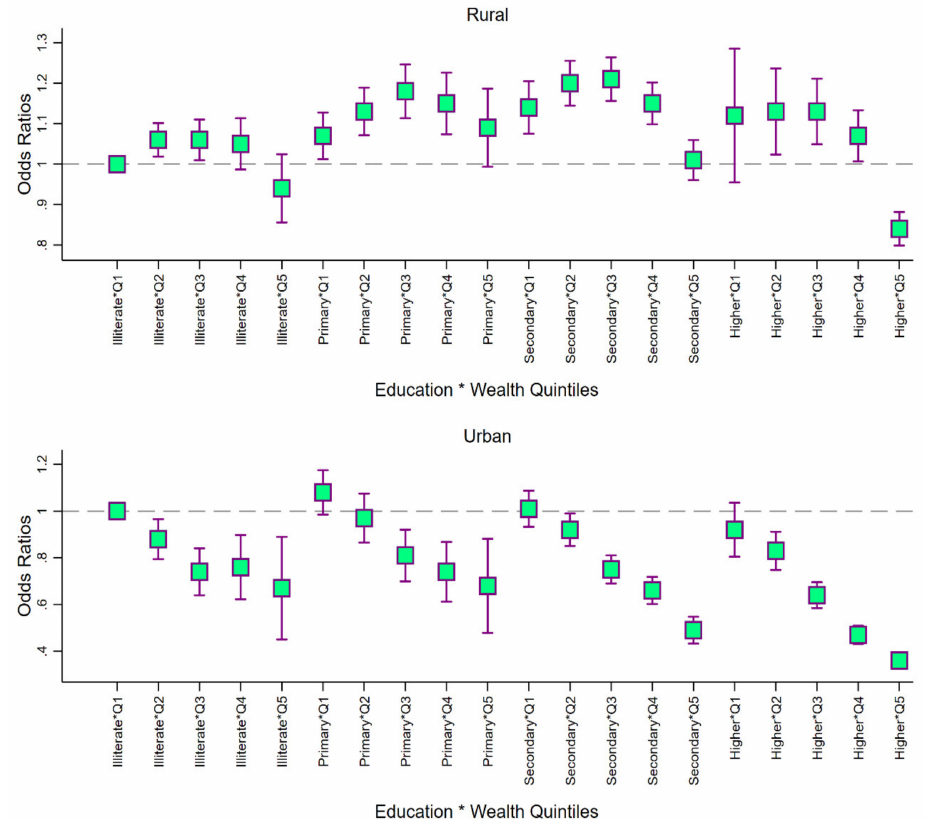
Figure 3. Adjusted odds ratios of service utilization (any) by education–wealth categories of mothers (during pregnancy), stratified by rural-urban location, NFHS, 2016. Note: Odds ratios estimated from a four level (state, district, cluster and individual) logistic regression adjusted for gender, social group and mothers’ age. Q1: lowest wealth quintile; Q2: second wealth quintile; Q3: third wealth quintile; Q4: fourth wealth quintile; Q5: highest wealth quintile.